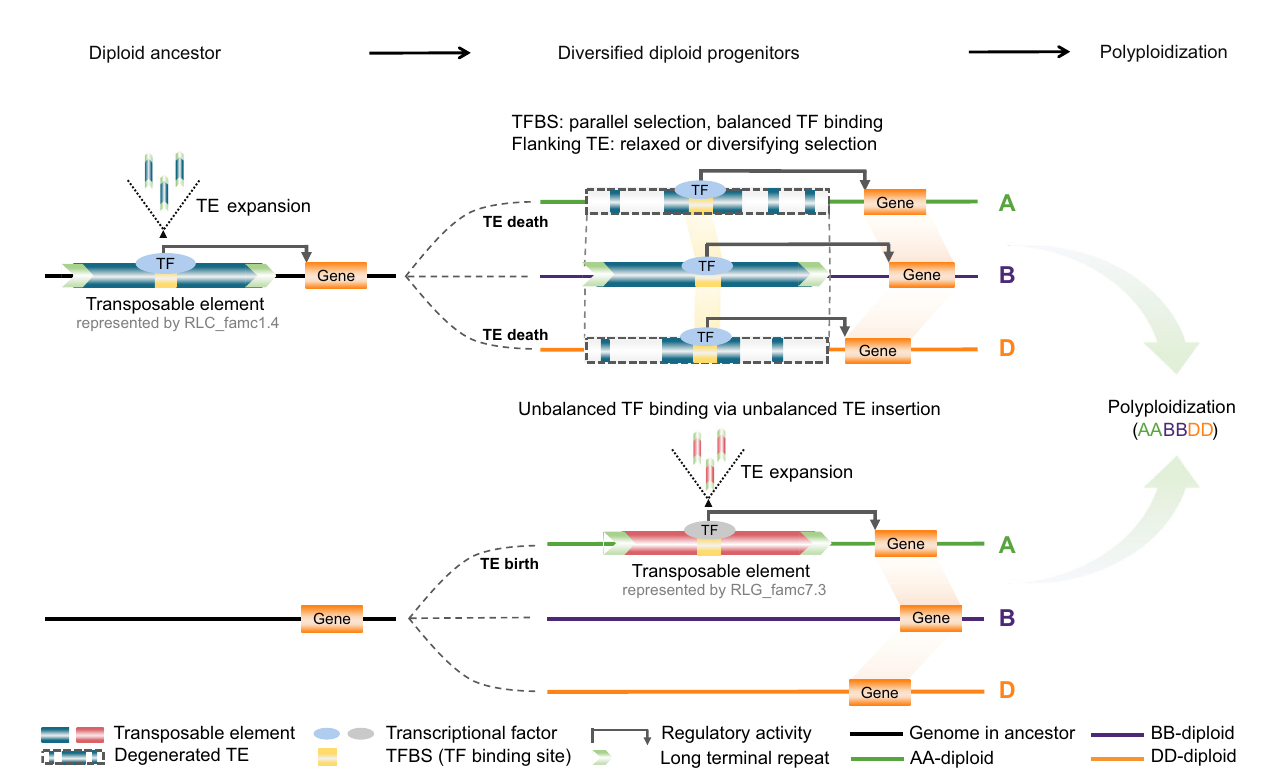
Fig.8|ModelillustratingtheeffectsofTE-derivedregulatoryconservationand innovation on subgenome-convergent and -divergent TF binding and tran- scription. Top:TE-embeddedTFBSsexpandedasTEsspreadintheA-B-Dcommon ancestor. In some cases, these TFBSs were maintained via parallel selection during the evolution of each diploid lineage after the divergence, whereas the fl anking TE sequences degenerated to varying extents, resulting in conserved TFBSs